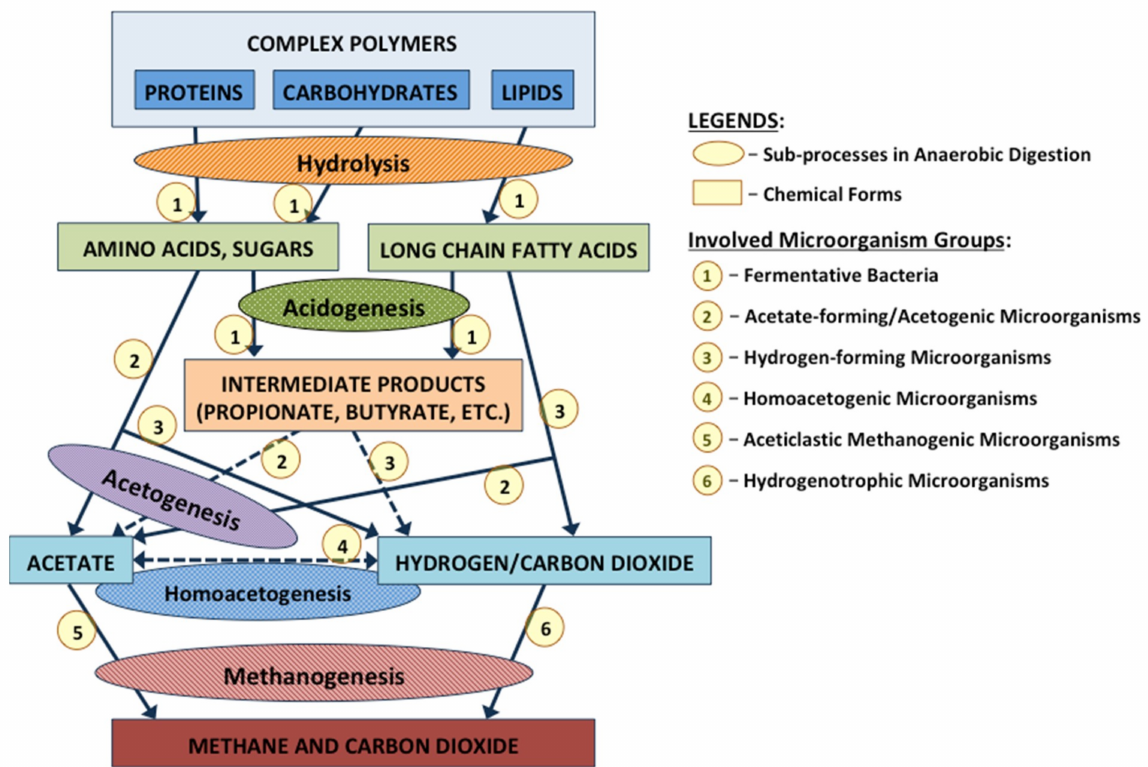
Figure 1. Anaerobic digestion of organic polymeric materials indicating sub-processes and involved bacterial groups (Figure adapted from Seghezzo, 2004